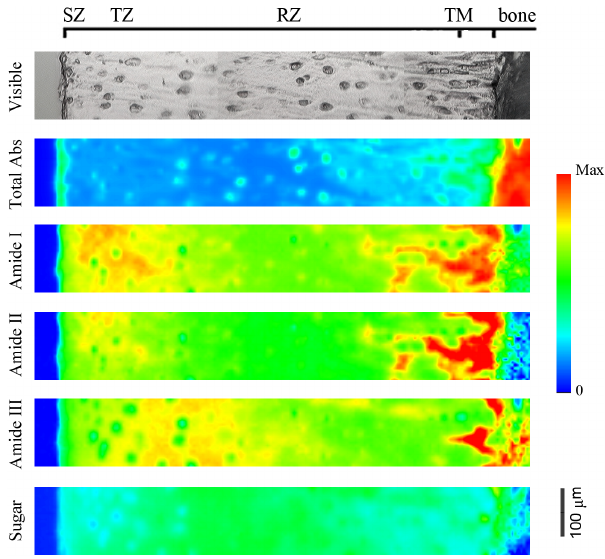
Fig. 2. A set of images of a typically healthy cartilage section, from the top to the bottom, including visible image, total IR absorption image, amides I, II, III images, and 1072 cm (cid:1) 1 sugar image, respectively. The same color scale was used to plot the FTIRIs, with the max absorptions for the images from the top to the bottom being 1.45, 0.5, 0.35, 0.15, and 0.30, respectively. The black bar presents 100 microns. The division of the histo- logical zones was based on the previous studies 14,16 : SZ: super¯cial zone; TZ: transitional zone; RZ: radial zone; TM: